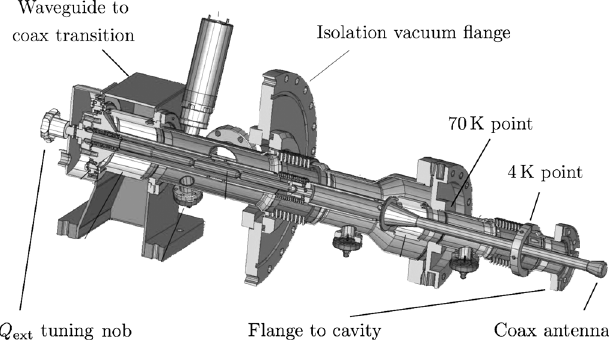
FIG. 4. Schematic drawing of the TTF-3 fundamental power coupler of the TESLA cavity. The waveguide (lower left end) connects the cavity with the rf power source and is at room temperature. A remote controlled stepper motor allows one to move the position of the coaxial antenna in the cavity beam pipe (right end).